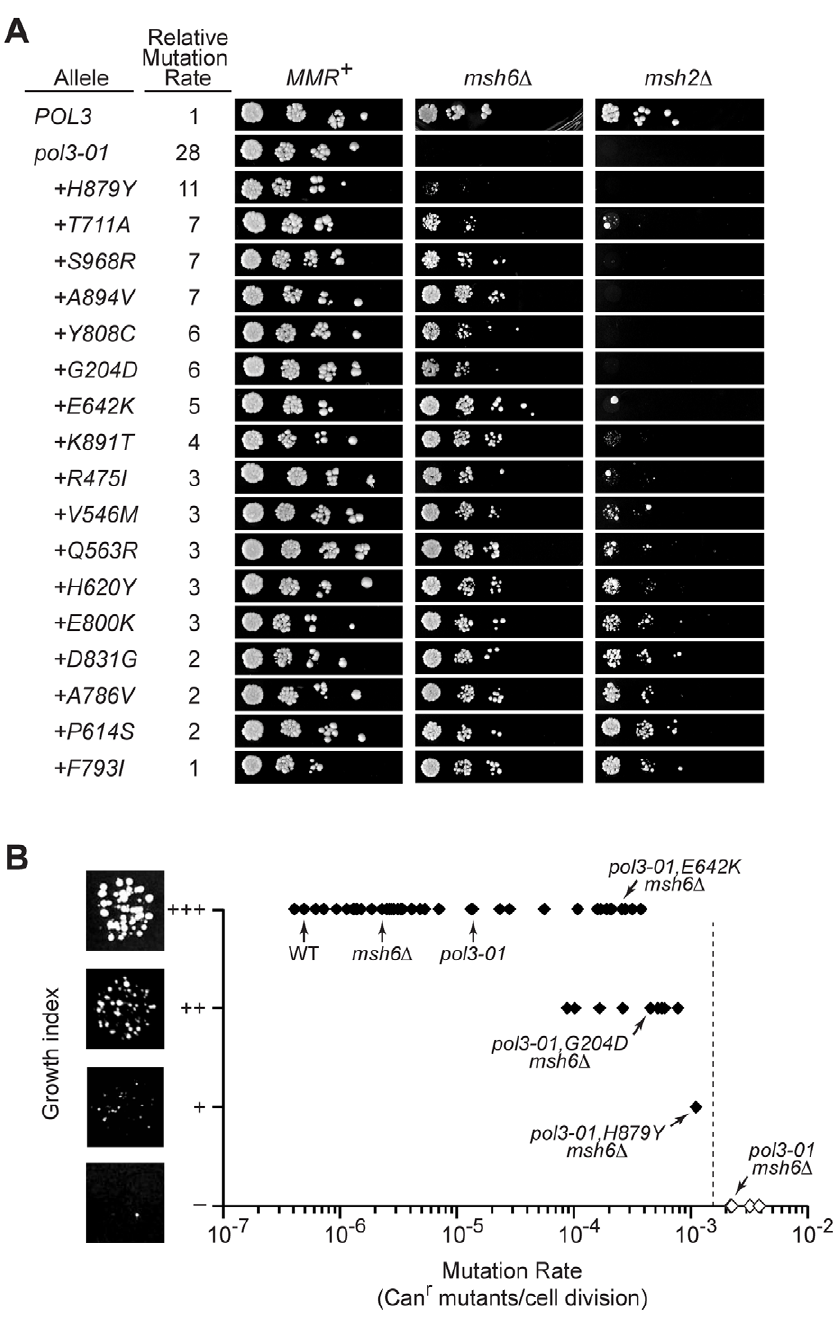
Figure 5. Defining the threshold of error-induced extinction. A) Plasmid shuffling experiments to reveal synthetic interactions between pol3- 01,eex alleles and MMR mutations. Ten-fold serial dilutions of yeast containing POL3–URA3 and pol3–LEU2 plasmids were plated on FOA-containing SC medium to select for cells that spontaneously lost POL3–URA3 . Similar numbers of colony forming units were plated for each set of alleles in the MMR + , msh6 D and msh2 D strains. Failed growth indicates synthetic lethality. Small colonies reflect slow-growth phenotypes. Relative mutation rates are the Can r mutation rates conferred by each pol3 allele relative to wild-type POL3 in MMR-proficient cells (see Table 1 and Table 2). Alleles are listed in decreasing order of mutator strengths. Some alleles with statistically similar mutation rates (as reflected by overlapping confidence intervals) have slightly different relative rates due to mathematical round-off. B) Relationship between growth capacity and CAN1 mutation rate for 62 haploid yeast strains. Colonies of pol3-01,E642K msh6 D , pol3-01,G204D msh6 D , pol3-01,H879Y msh6 D , and pol3-01 msh6 D cells are shown to illustrate wild-type ( +++ ), moderately defective ( ++ ), severely defective ( + ), and failed (–) growth, respectively. The vertical dashed line indicates the estimated maximal mutation rate compatible with haploid yeast colony formation, which is our functional definition of the replication error threshold. Filled symbols, rates measured by fluctuation analyses. Open symbols, rates estimated as described in the text. Data in brackets with an asterisk (*) are pol3-01,T711A msh6 D , pol3-01,S968R msh6 D , pol3-01,G204D msh6 D , and pol3-01,Y808C msh6 D .